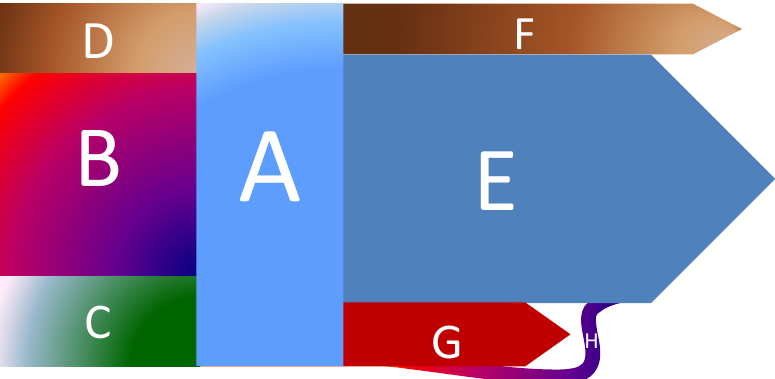
Figure 4. The energy outline at the power distribution grid level. A—Available Energy, F—Output exchange energy, E—Net energy delivered to consumers, D—Distribution grid interconnection, B—Electric power transmission interconnection, C—Local produced energy, G—OTC, H—Recovered